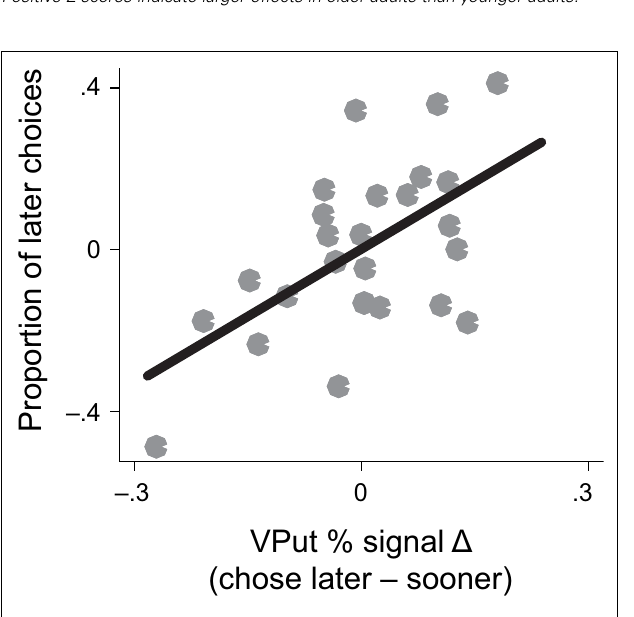
FIGURE 4 |Activity in the ventral putamen (VPut) was associated with behavioral individual differences. Individuals with higher levels of signal change in theVPut on trials where they chose the later option relative to the sooner option also made more later choices